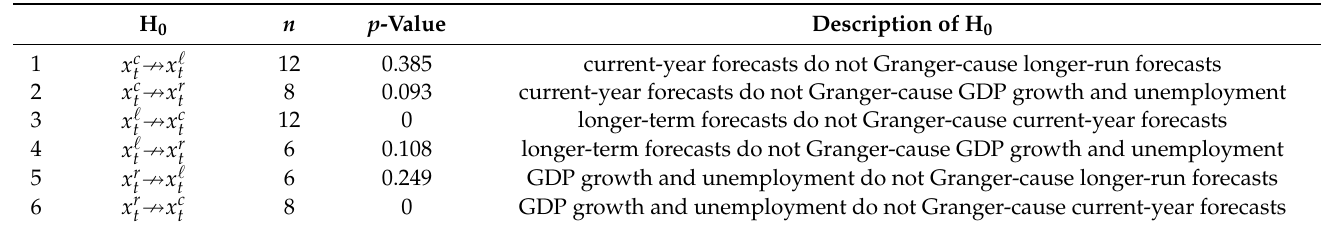
Table 1. Granger Causality Tests: